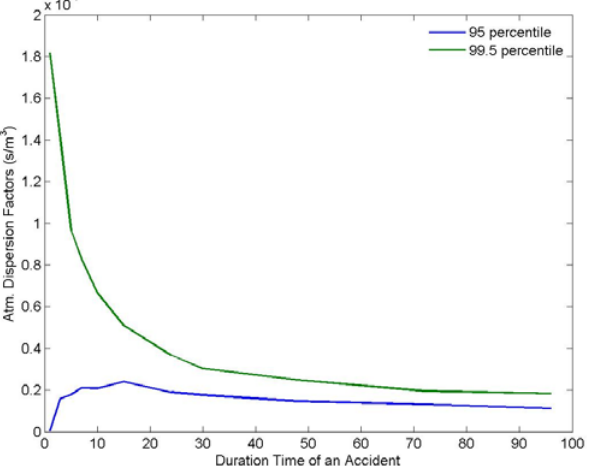
Figure 4. Variations of atmospheric dispersion factors by the duration time of radioactive effluents in the highly populated